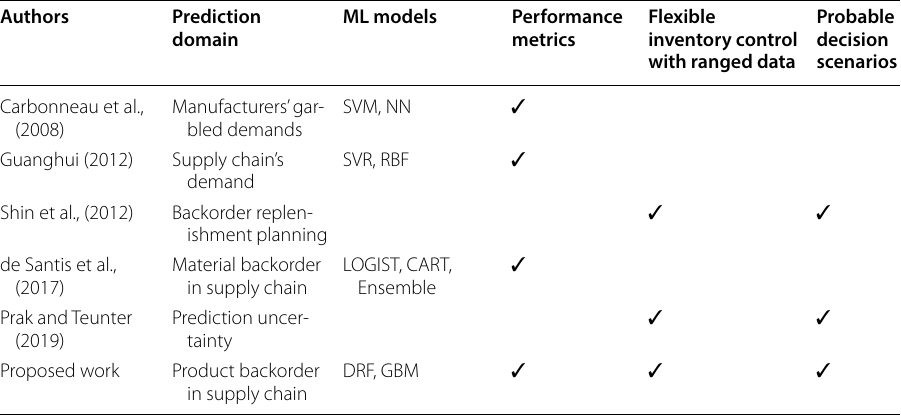
Table 1 Review of the related papers